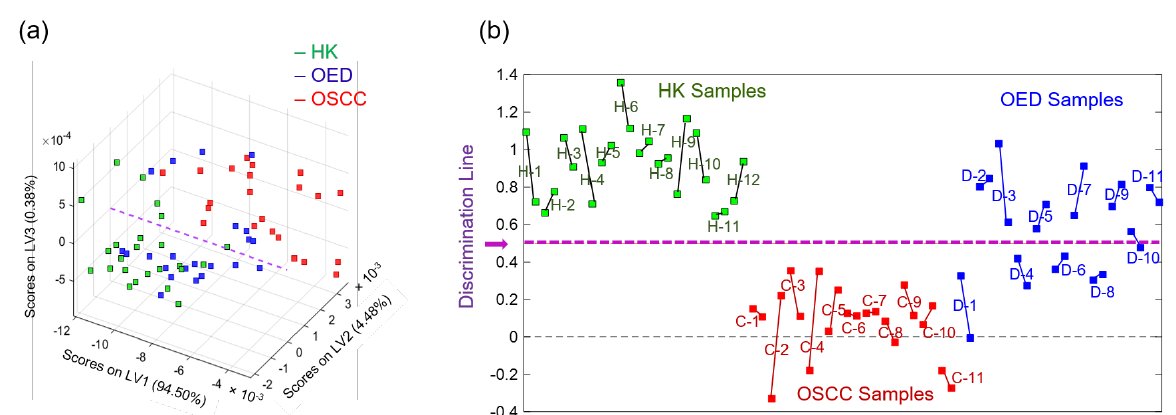
Figure 8. ( a ) Score plot for the top three latent variables (LV1–LV3) of the partial least square discriminant analysis (PLSDA) model; ( b ) visual illustration of the discrimination of all 34 samples by the PLSDA model (H for HK samples, C for OSCC samples, and D for OED samples).